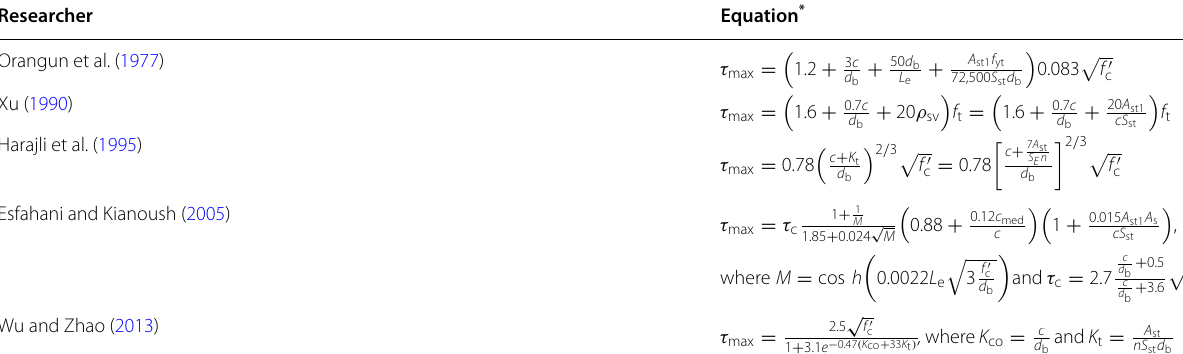
Table 1 Empirical bond strength models.